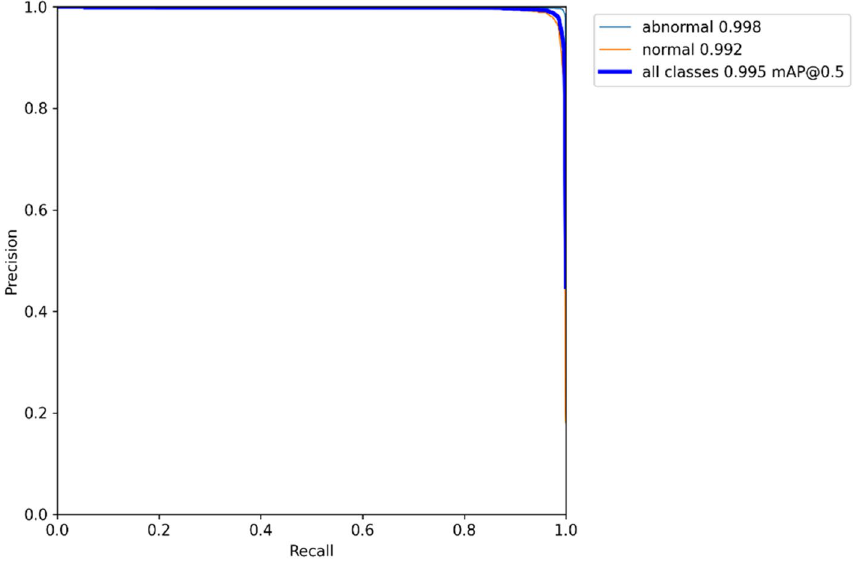
Figure 6. Precision-recall